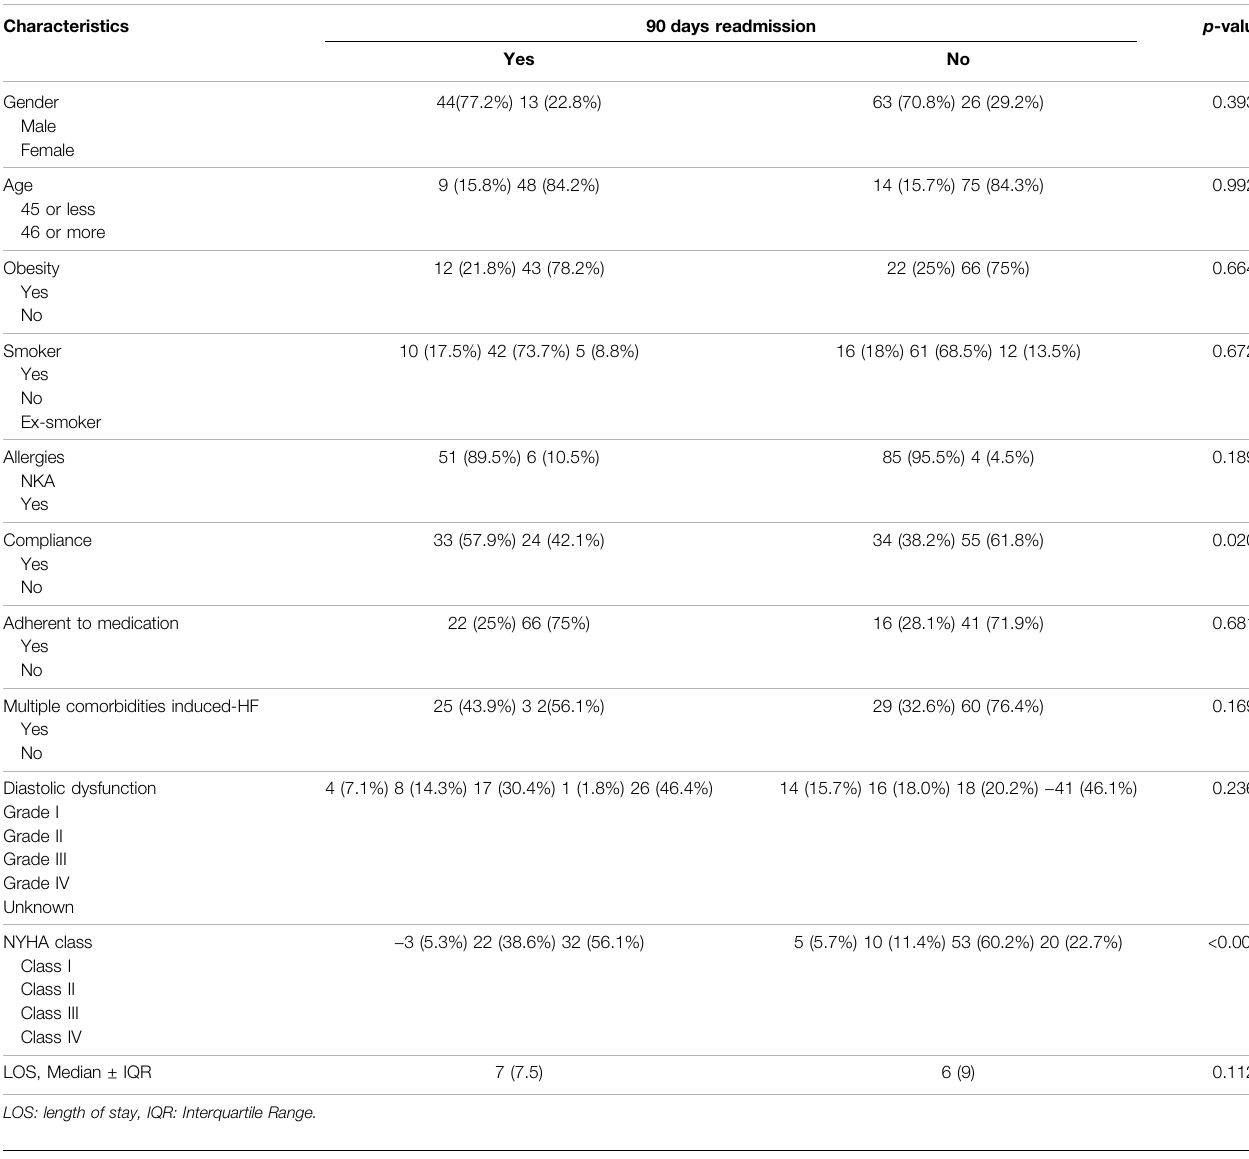
TABLE 7 | Factors associated with readmission.